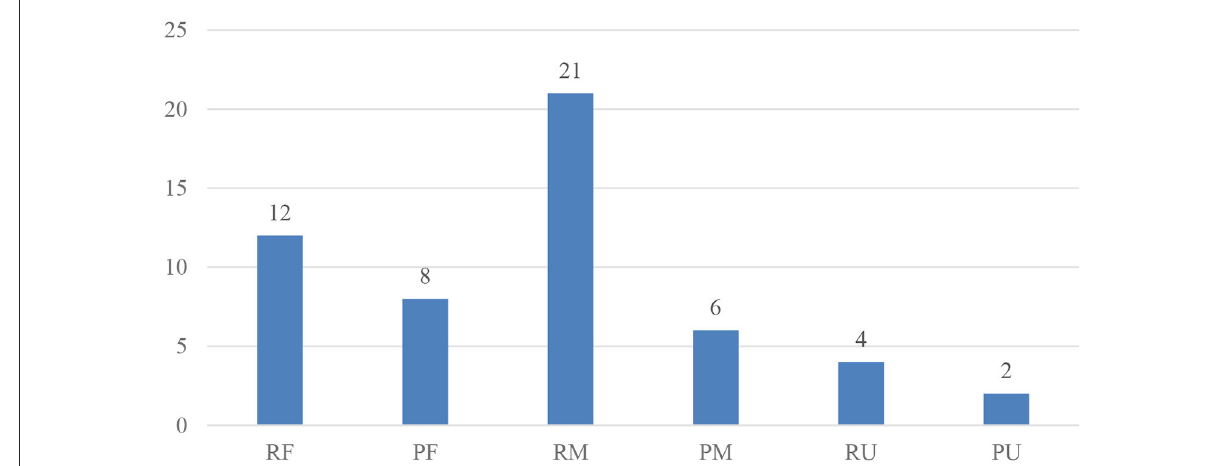
FIGURE3 Frequency of word knowledge type ( k 29). Max 29 as only 29 of the 32 studies provided necessary data. RF, receptive knowledge of form; = = PF, productive knowledge of form; RM, receptive knowledge of meaning; PM, productive knowledge of meaning; RU, receptive knowledge of use; PU, productive knowledge of use. As more than one aspect of word knowledge might have been assessed within a single study, the total is higher than